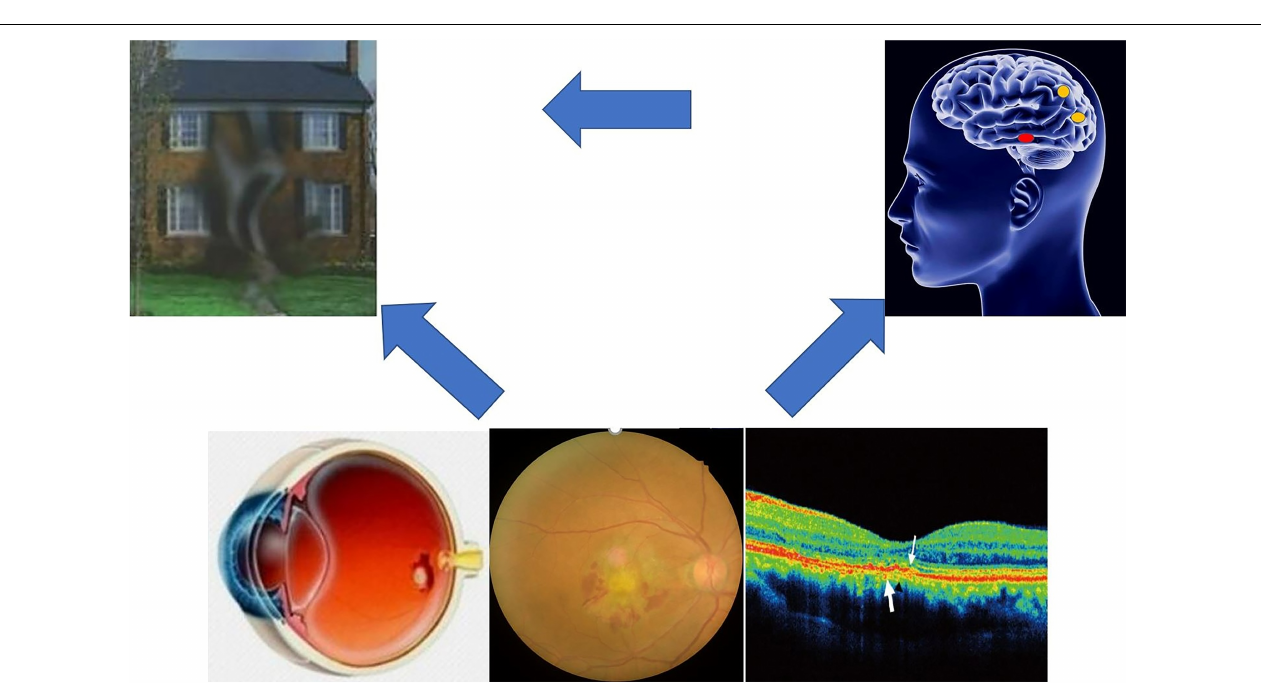
FIGURE 6 | The ReHo results of brain activity in the AMD group. Compared with the HCs, the ReHo values of the following regions were decreased to various extents: 1- Cingulate Gyrus/Superior Frontal Gyrus (BA 32, t = 6.1903), 2- Middle Frontal Gyrus/Inferior Parietal Lobule/Precentral Gyrus ( t = 5.9303). Compared with the HCs, the ReHo values of the following regions were increased to various extents: 3- Limbic Lobe/Parahippocampal Gyrus ( t = − 5.0146). HCs, healthy controls; BA, Brodmann’s area.